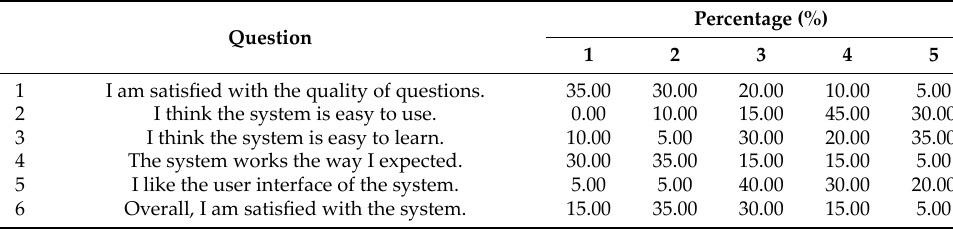
Table 2. Results of the user survey.